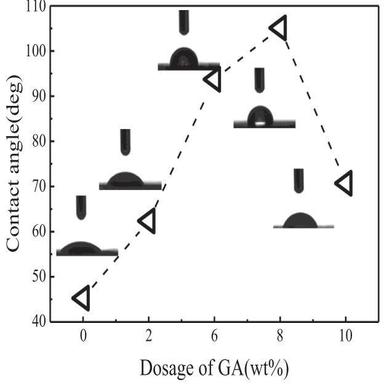
Contact angle curves of PVA/PCM fibers and cross-linked PVA/PCM fibers in different dosages of GA.